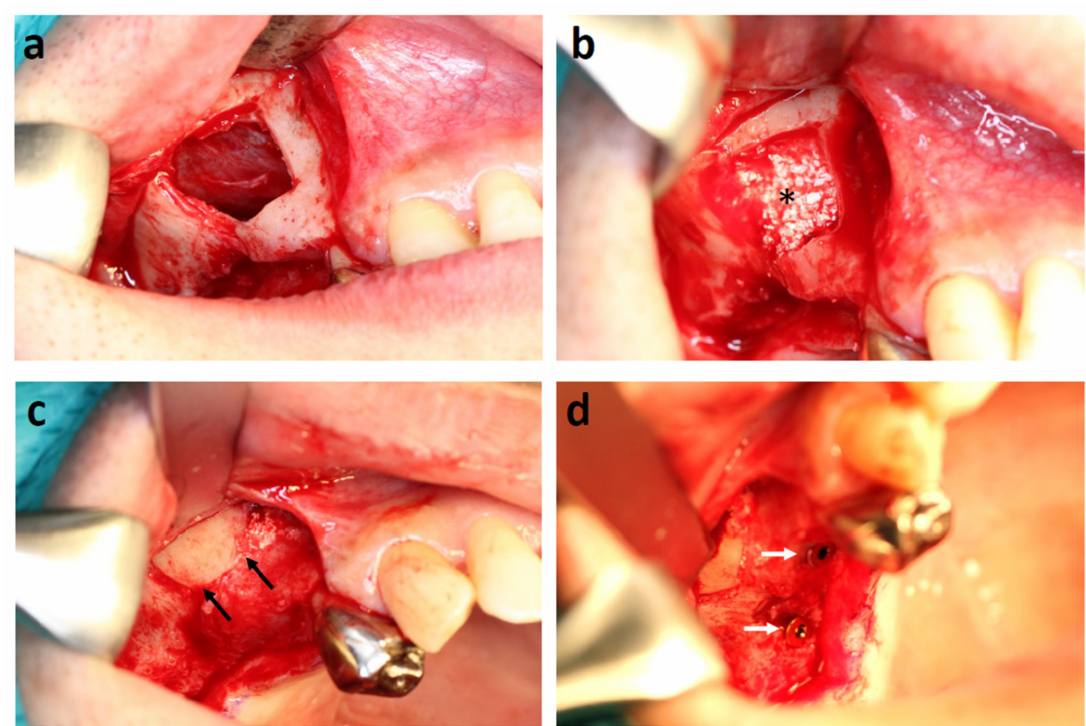
Figure 3. Representative case of maxillary sinus floor augmentation. ( a ) Elevation of the Schnei- derian membrane. ( b ) Tissue-engineered bone filled into the space between the alveolar bone and Schneiderian membrane (asterisk indicates tissue-engineered bone). ( c ) Regenerated alveolar bone at 16 weeks after transplantation (black arrows indicate transplanted site). ( d ) Dental implant installation (white